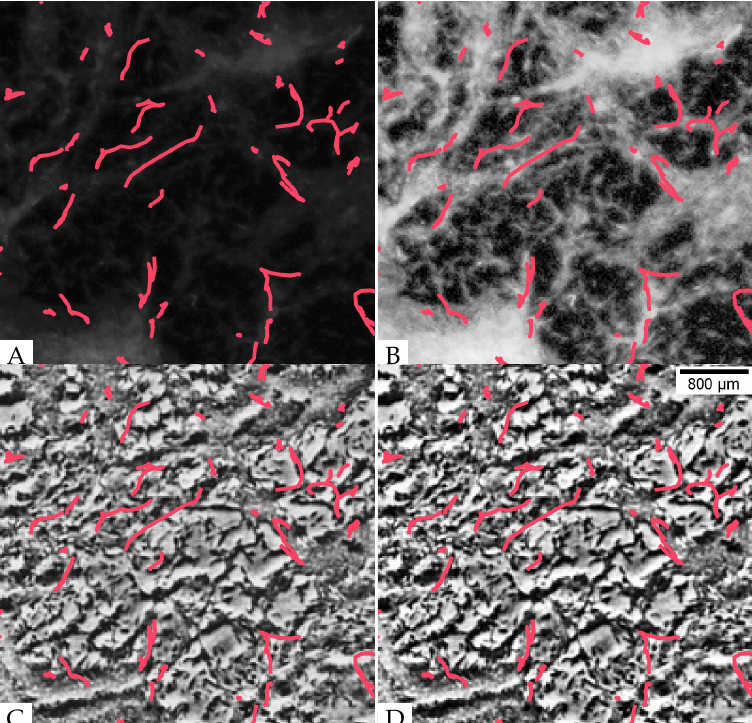
Figure 4. Fluorescent images best represent interaggregate stream patterns. Trajectories of tdTomato- expressing LS3908 cells were tracked over 15 min as they moved through a starving population of GFP-expressing DK10547 cells. Trajectories are superimposed over the corresponding ( A ) GFP fluorescent image, ( B ) histogram-equalized GFP fluorescent image, ( C ) phase-contrast image, and ( D ) histogram-equalized phase-contrast